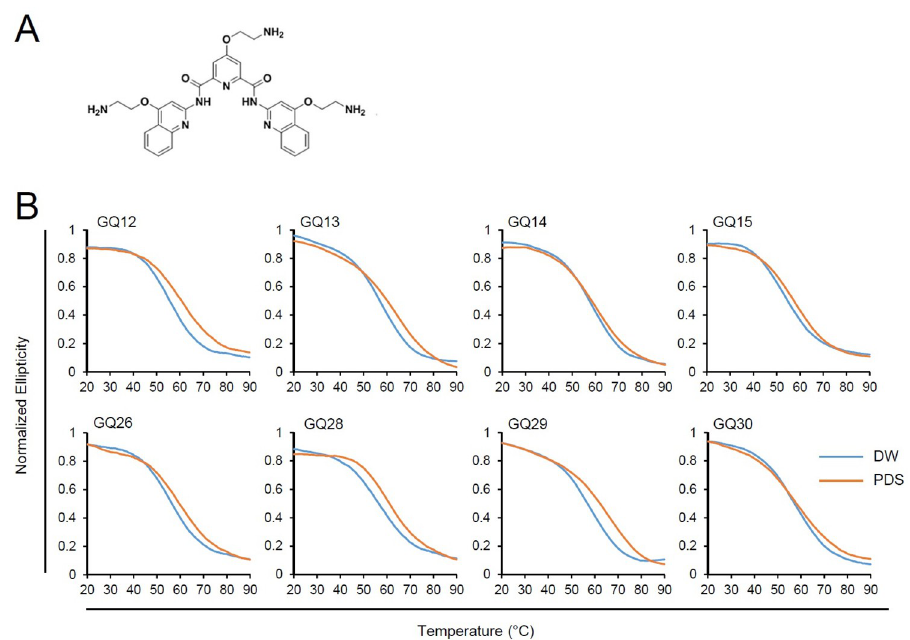
Fig 5. Effect of PDS on thermal melting curves of ORF14 G4s. (A) Chemical structure of PDS. (B) The CD melting curves of ORF14 GQ ODNs from pOka in the presence of DMSO and PDS are compared. GQ ODNs (15 μ M) were annealed in the presence of 10 mM Tris-HCl (pH 7.5) and 100 mM KCl buffer with DMSO or 30 μ M PDS (DNA to chemical ratio 1:2). The CD melting graph was calculated at 290 nm wavelength for all GQ ODNs. The melting curves obtained with mean values from triplicate results are shown. The data were normalized using the maximum ellipticity and smoothed using GraphPad Prism 5.